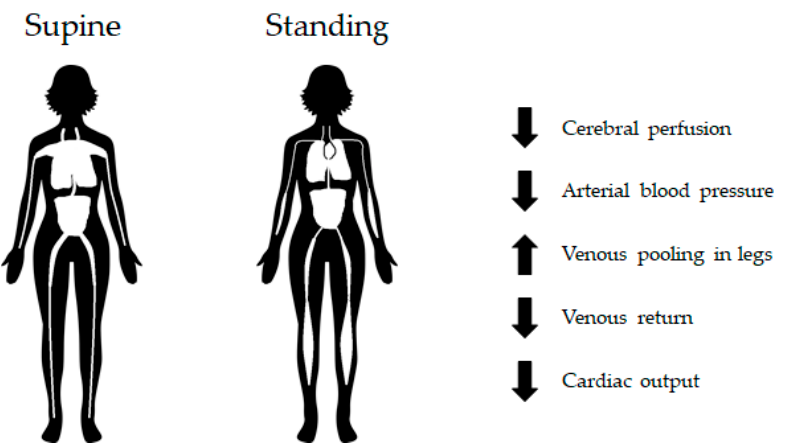
Figure 3. Orthostatic stress diagram. In a standing position, gravitational stress induces a downward shift in blood volume. This figure illustrates the result of cardiovascular deconditioning; that is, the inability of the cardiovascular system to maintain adequate blood pressure and brain perfusion. Increase (↑ ); decrease ( ↓ ).